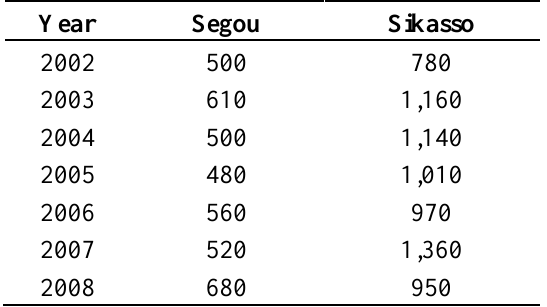
Table 2. Segou and Sikasso annual rainfall (mm) from 2002 to